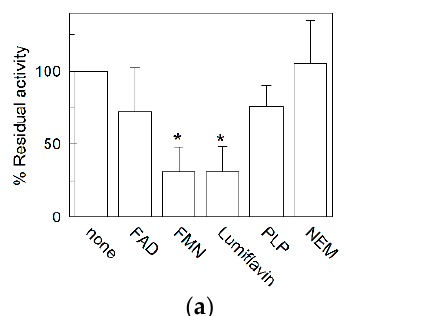
amino acid residues of proteins have been tested. Pyridoxal 5 (NEM), which interact with amino groups of Lysine or thiol groups of cysteine, respectively, did not exert significant e ff ects.